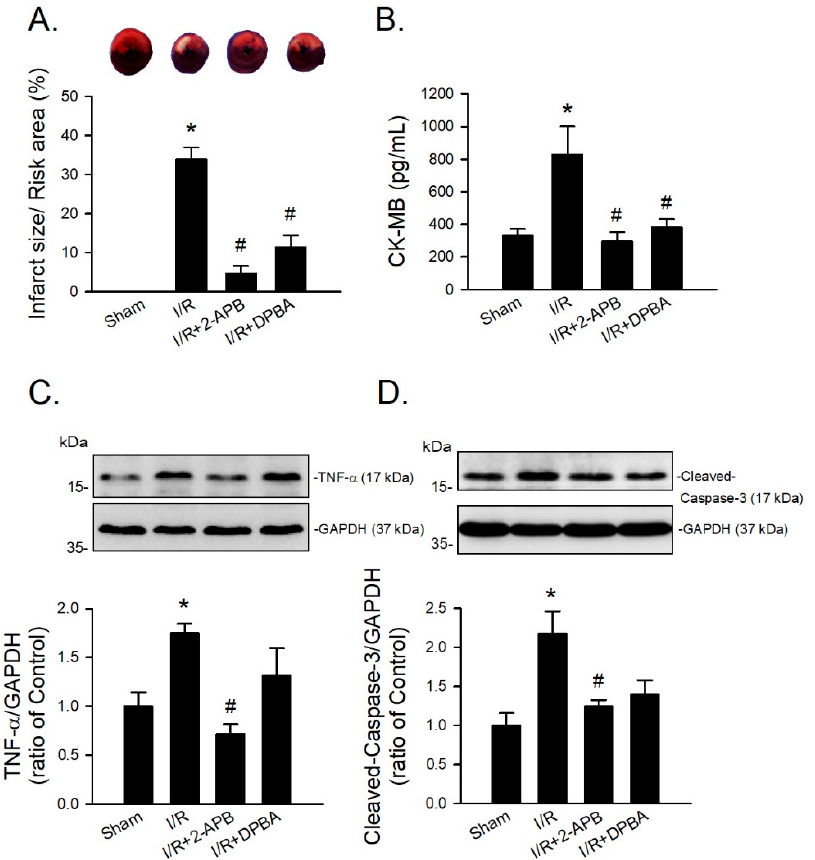
Figure 7. Protective effects of 2-APB and DPBA on the I/R-induced myocardial infarction, inflammation, and apoptosis in an in vivo I/R model. ( A ) Both 2-APB and DPBA at a concentration of 3 mg/kg significantly decreased infarct size/risk area induced by I/R. ( n = 4). ( B ) Both 2-APB and DPBA at a concentration of 3 mg/kg significantly decreased the levels of creatine kinase-MB (CK-MB). ( n = 4). 2-APB (3 mg/kg) significantly reduced the levels of TNF- α ( C ), and cleaved-caspase-3 ( D ). Top panel shows representative Western blot analyses. Bottom panel shows graphs of quantification of these data adjusted with GAPDH protein level and expressed as ratio over the corresponding control. ( n = 4). * p < 0.05 different from the sham group; # p < 0.05 different from the I/R group. Data are expressed as mean ± SEM. Abbreviations: CK-MB, creatine kinase-MB; GAPDH, glyceraldehyde 3-phosphate dehydrogenase; I/R, ischemia/reperfusion; TNF- α , tumor necrosis factor- α